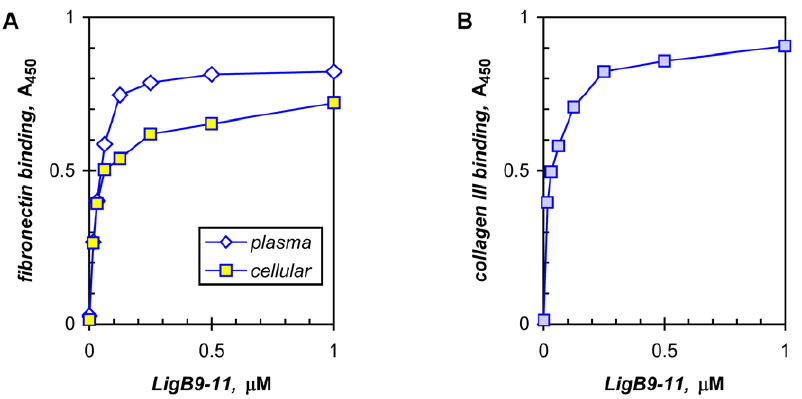
Figure 2. LigB binds cellular fibronectin and collagen type III. A recombinant LigB protein was tested in an ELISA for binding to A ) human plasma and cellular fibronectin and B ) human type III collagen.